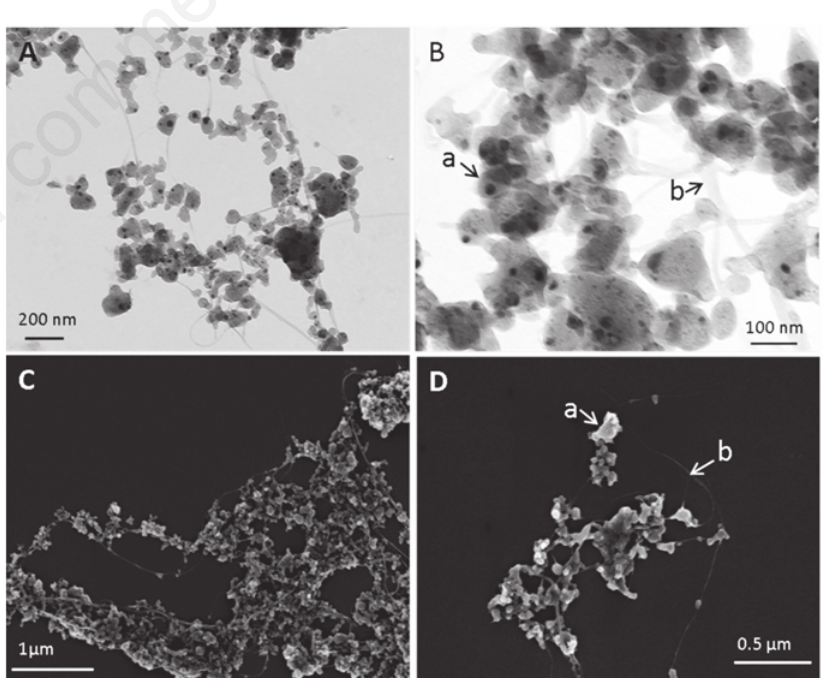
Figure 1. Single-walled carbon nanotubes (SWCNT) solubilized in M4 medium observed with field emission gun scanning electron microscopy (A and B) and transmission elec- tron microscopy (C and D). Both techniques allow visualization of carbon nanotubes (a) and impurities (b) forming rounded